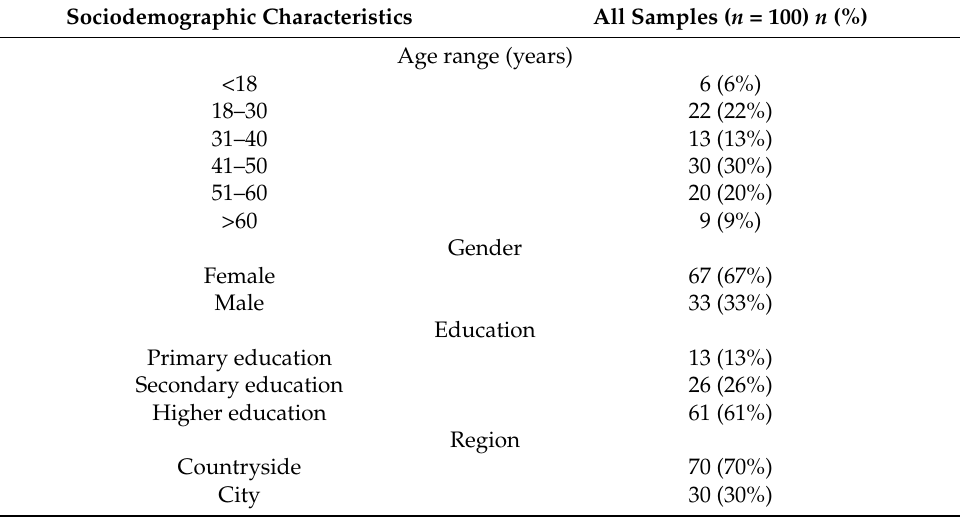
Table 5. Sociodemographic characteristics of the 100 volunteers. Sociodemographic